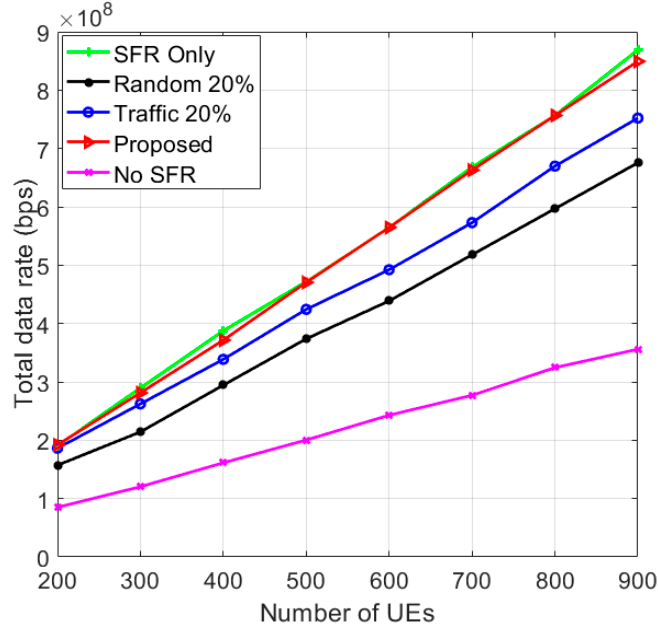
Figure 12. Total system data rate for different numbers of UEs.